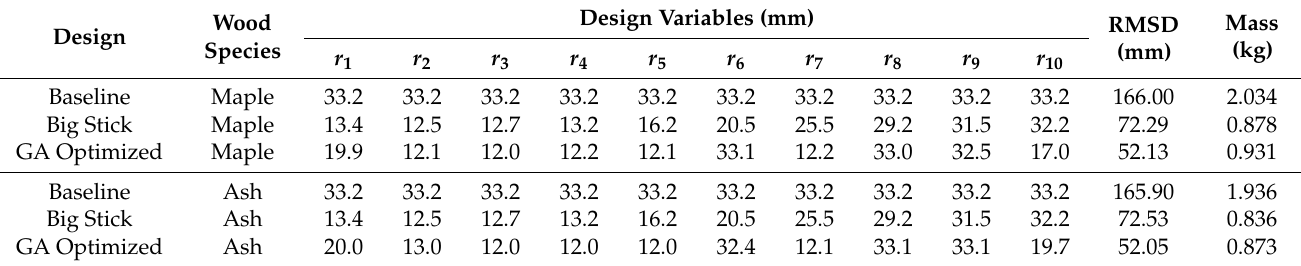
Table 2. Optimization parameters for the baseline, GA and hybrid optimized